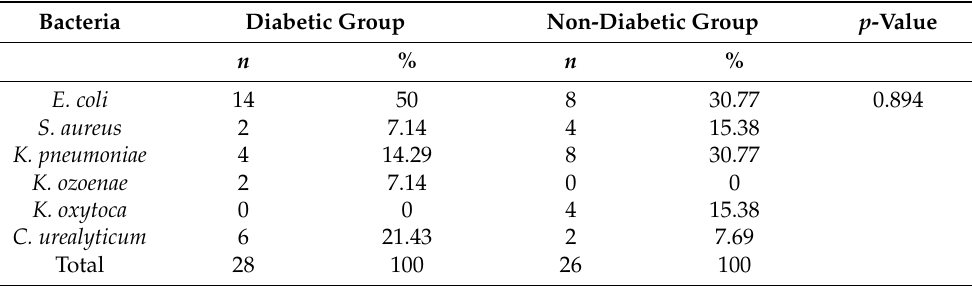
Table 2. Bacterial isolates identified from diabetic and non-diabetic patients.